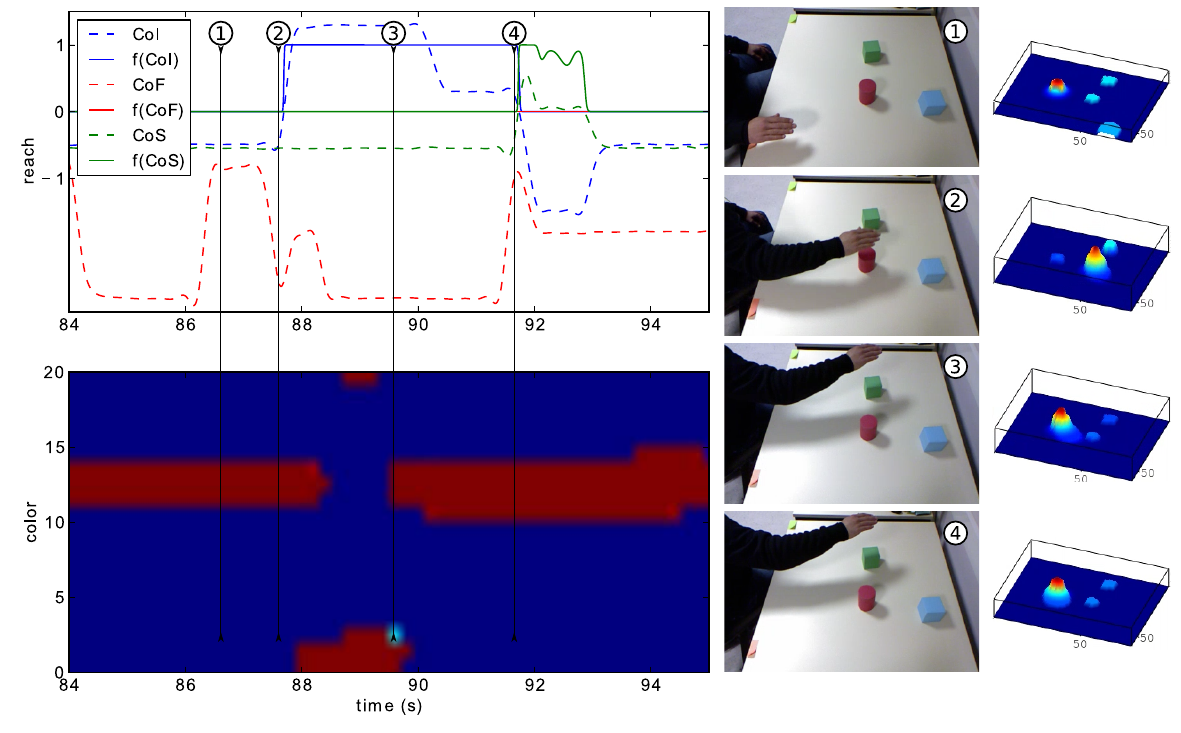
Figure 11: Continuous update and reselection of the hypothesized target object of an